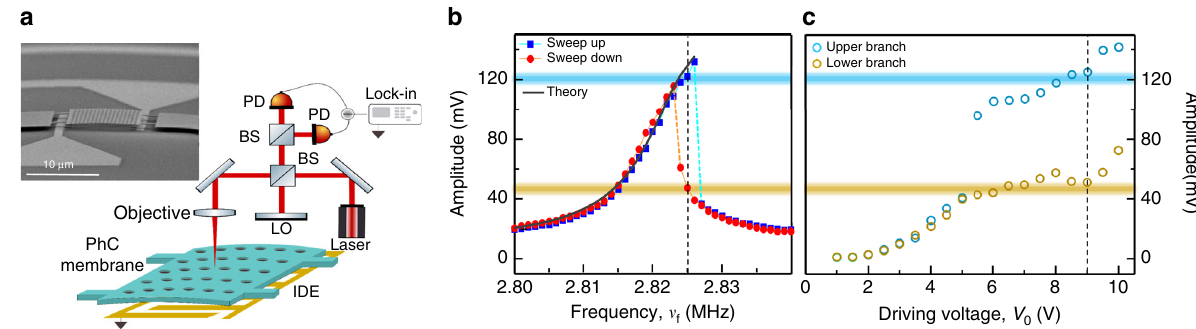
Fig. 1 Nonlinear characterization of the nano-electromechanical resonator. a Schematic of the experimental set-up used for the actuation and detection of the mechanical motion of the membrane (PhC photonic crystal, IDE interdigitated electrodes, LO local oscillator, BS beamsplitter, PD photodiode). Inset: scanning electron microscopic image of the resonator consisting of a suspended InP membrane with a thickness of 260 nm and a surface of 20 × 10 μ m 2 and integrating gold interdigitated electrodes underneath at a 400-nm distance. b Amplitude of the forced mechanical fundamental mode as a function of the forcing frequency ν f in a sweep up (blue dots) and sweep down (red dots) experiment for V 0 = 9 V . A theoretical fi tting of the forced amplitude response curve (sweep up) is shown (black line). The vertical dashed line lies at a frequency of 2.825MHz. c Amplitude of the forced mechanical fundamental mode as a function of the amplitude of the applied voltage V 0 for a forcing frequency fi xed at ν f = 2.825 MHz. The vertical dashed line lies at a voltage amplitude of 9 V